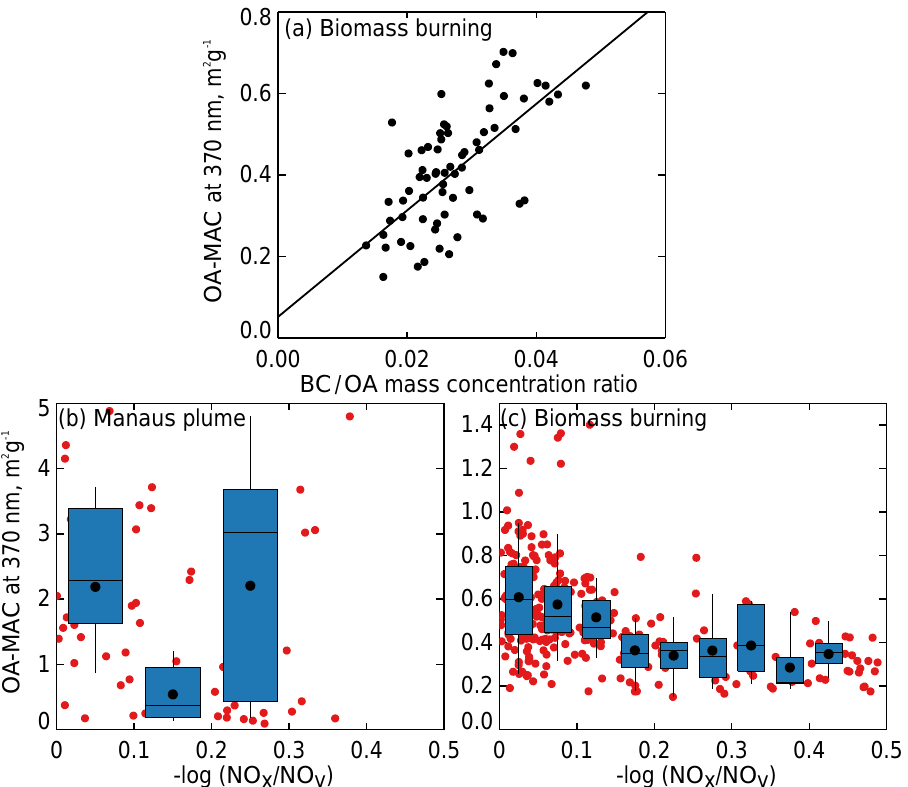
Figure 10. Measurements from the GoAmazon2014/5 campaign at the T3 site, to the west of Manaus, Brazil. The relationship between hourly mean BrC-MAC measured at 370nm and (a) the observed BC / OA ratio during 15 August–15 October 2014 (IOP2), as well as (b) the measured photochemical clock during January–March 2015 with selected Manaus plumes and (c) IOP2, excluding Manaus plumes. In (b) and (c) , the red points are individual hourly average measurements, whereas the box-and-whisker plots show the binned mean (black points), median (black lines inside boxes), lower and upper quartile (boxes), and 5th and 95th percentile